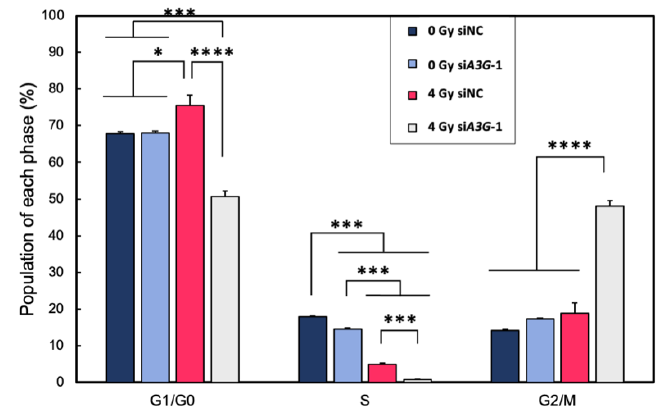
Figure 3. Radiosensitization effects of A3G knockdown on lung cancer A549 cells. ( Top ) Cell cycle analysis of A3G- knockdown A549 cells with siA3G-1 on cell cycle distribution 24 h after γ -irradiation at 4 Gy. ( Bottom ) Population of cells in G0/G1, S, and G2/M phases. Values represent mean ± SE from 3 independent experiments. *, p < 0.05; ***, p < 0.001; ****, p < 0.0001.